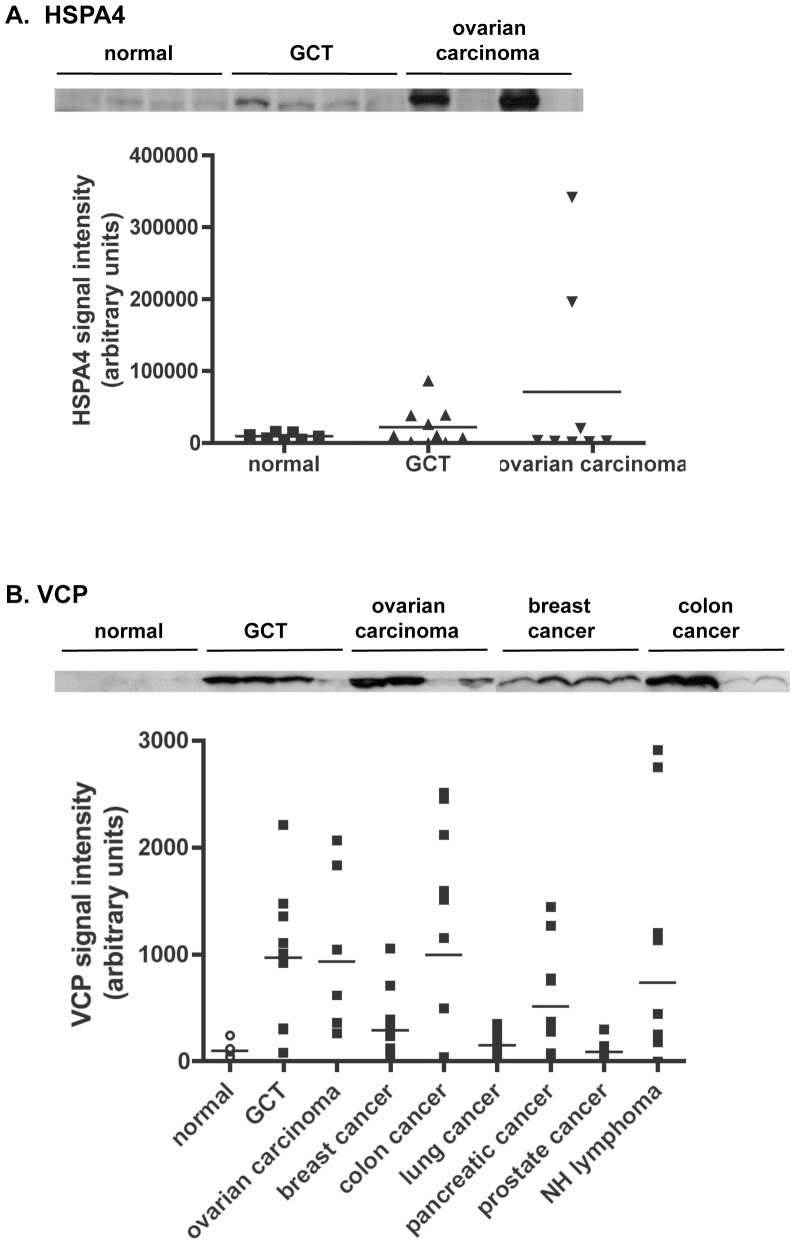
Serum levels of HSPA4 and VCP in healthy volunteers and in cancer patients.(A) HSPA4 levels in the serum of women with GCT or ovarian carcinoma. Equal amounts of serum protein were separated by SDS-PAGE and were subjected to immunoblot analysis for HSPA4 levels (representative blots are shown in the top panel, each lane represents a single donor). Densitometry analyses of signals obtained with the HSPA4 immunoblot analyses are reported in a graph in which each dot represents a single donor (bottom, horizontal bar = mean). No significant difference in HSPA4 levels was detected among groups by one-way ANOVA. (B) VCP levels are increased in the serum of cancer patients. Sera were analyzed as in (A) for the presence of VCP in patients with breast, colon, lung, pancreatic or prostate cancer, ovarian carcinoma, GCT, or non-Hodgkin's (NH) lymphoma. Statistically significant differences (P<0.05) were detected between the control (normal) and GCT and colon cancer groups.